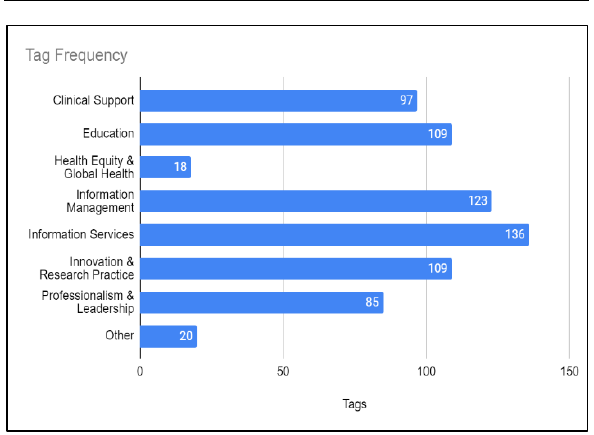
Figure 1: Total tag